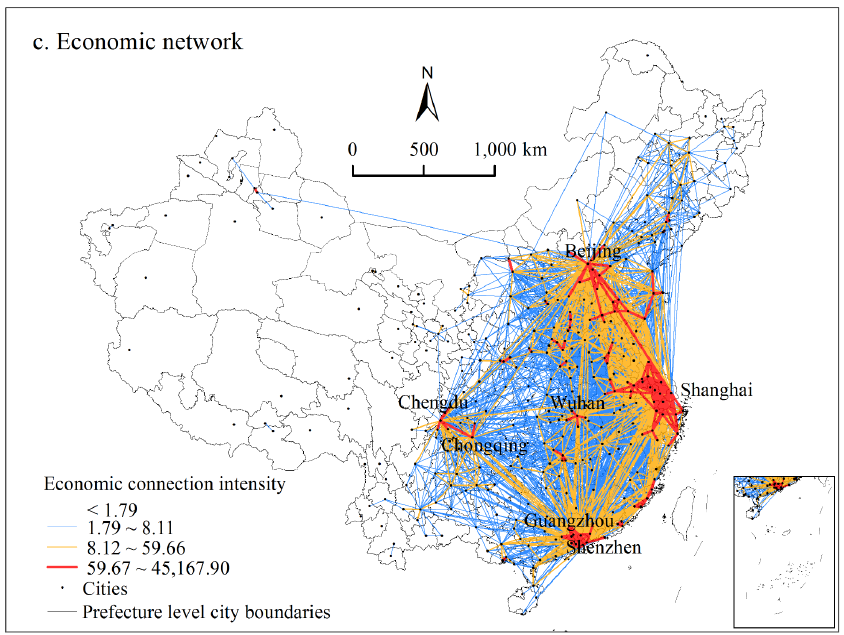
Figure 3. Spatial patterns of urban networks: ( a ) information network; ( b ) transportation network; ( c ) economic network. The information network is shown in Figure 3a; it contains 53,254 connection routes.